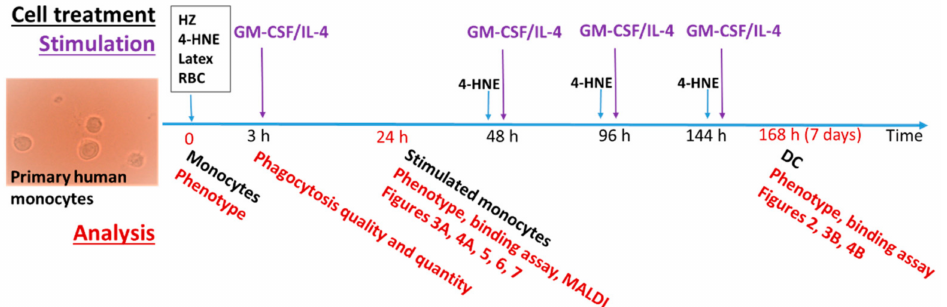
Figure 1. Scheme of experimental design. Experiment was started when adherent human monocytes were supplemented with hemozoin (HZ), 4-hydoxynonenal (4-HNE), latex beads (Latex), or RBC. The phagocytosis was completed in 3 h, when non-phagocytosed material was washed out. Monocytes were differentiated to DC during 7 days by supplementation with GM-CSF and IL-4 every 48 h. 4-HNE and GM-CSF/Il-4 were repeatedly added after culture medium changes, as shown in the diagram. Performed analysis and figures which summarise obtained data are indicated at respective points below the